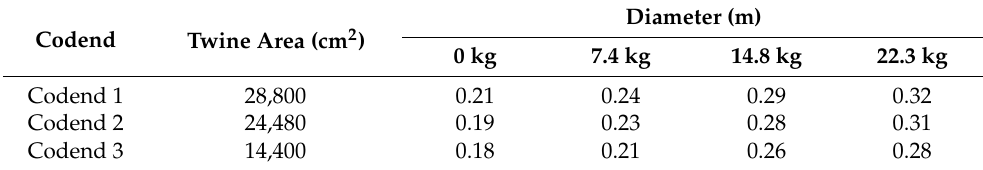
Figure 3. Schematic diagram of the experimental setup to measure the hydrodynamic forces, flow velocity, shape, and the motion of the codend model. Table 2. The twine area and the diameter of the three trawl